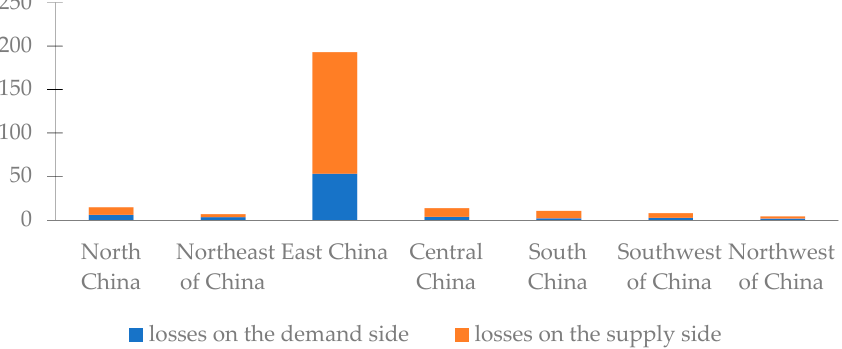
Figure 4. Indirect economic losses on the demand/supply side of various regions in China (unit: CNY 100 million). Table 4. Related losses of various regions in China (unit: CNY 100 million).